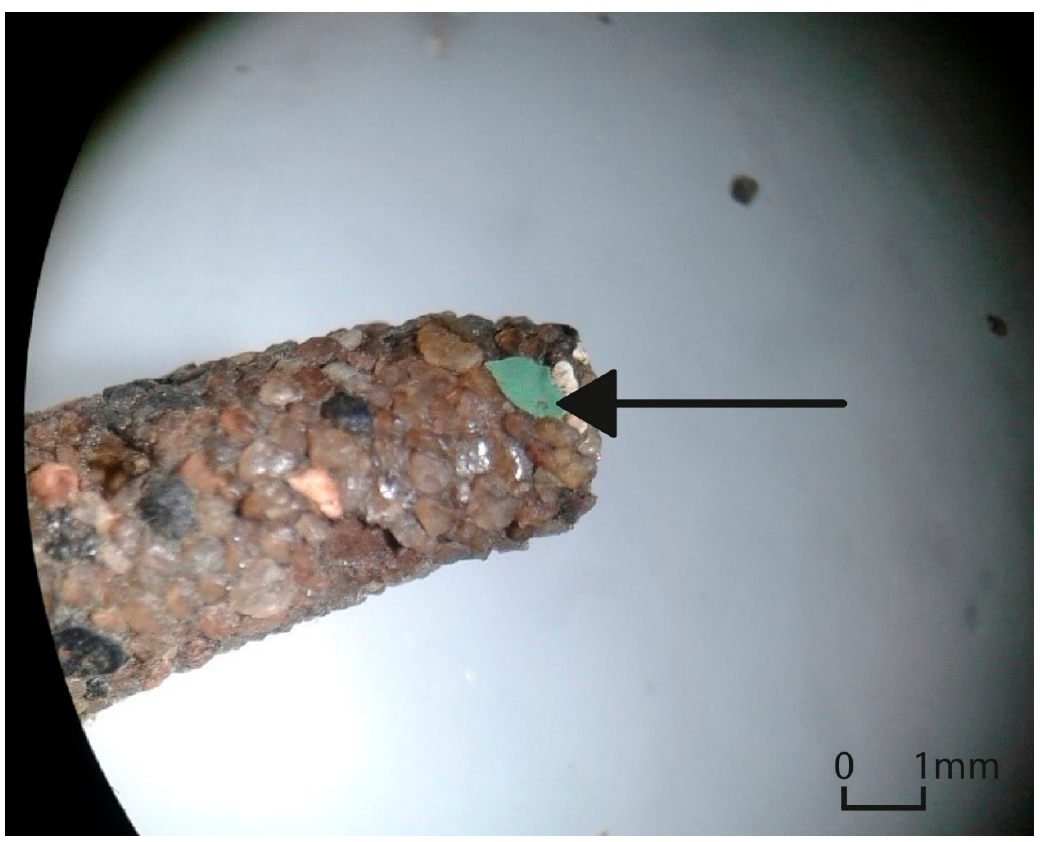
Figure 4. Example of a microplastic particle (indicated with an arrow) incorporated into caddisfly casing. Microplastic particle is ~1 mm in length.